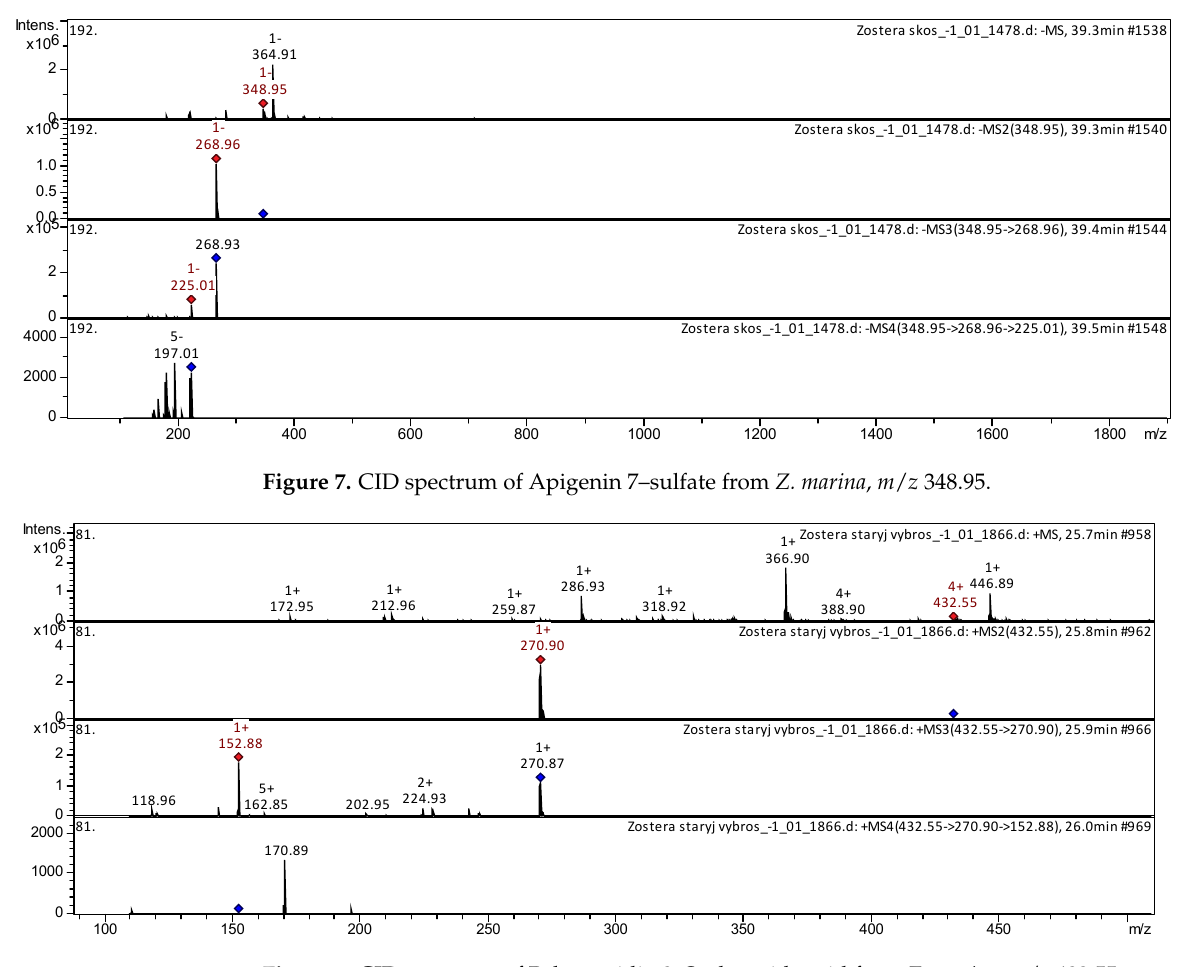
6 of 21 Figure 6. CID spectrum of Luteolin 7–sulfate from Z. marina , m/z 366.82.